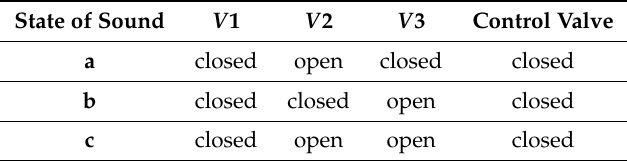
Table 1. Valve settings for the states of sound a,b, and